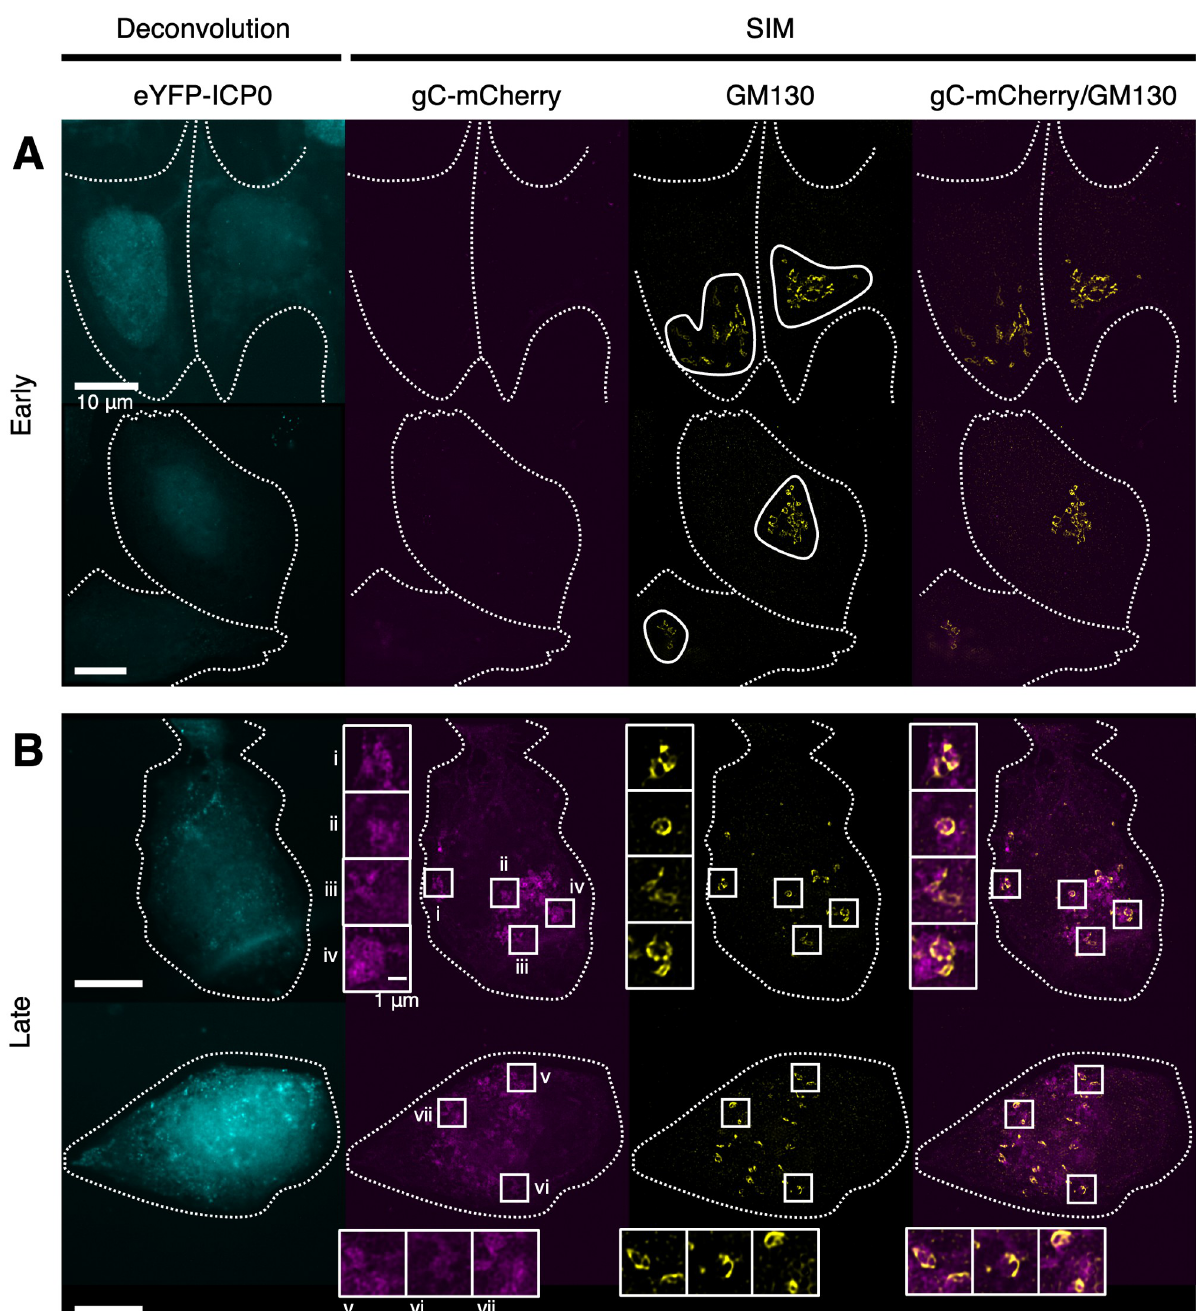
Fig 6. Fragmentation and dispersal of cis -Golgi membranes during HSV-1 infection. U2OS cells infected (MOI 3) with timestamp HSV-1 were fixed at 6 hpi and imaged by SIM and deconvolution microscopy. GM130 immunolabelling was used to identify cis -Golgi membranes [107]. Dotted outlines denote the cell boundaries. ( A ) Cells at early stages of infection were identified by the presence of eYFP-ICP0 signal using deconvolution microscopy and by the absence of high gC-mCherry signal using SIM. GM130 + membranes, which appeared clustered at early stages of infection, are outlined. ( B ) Cells at late stages of infection were identified by the presence of high gC-mCherry signal. GM130 + membranes were dispersed and fragmented in these cells. Boxes (i–vii) and corresponding insets showing adjacent localization of GM130 and gC-mCherry.